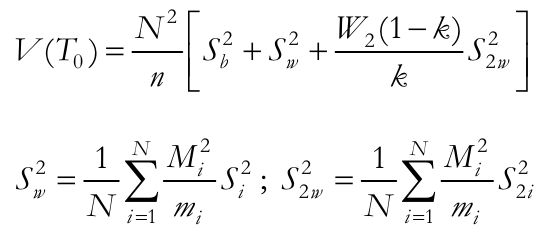
Efficiency of T